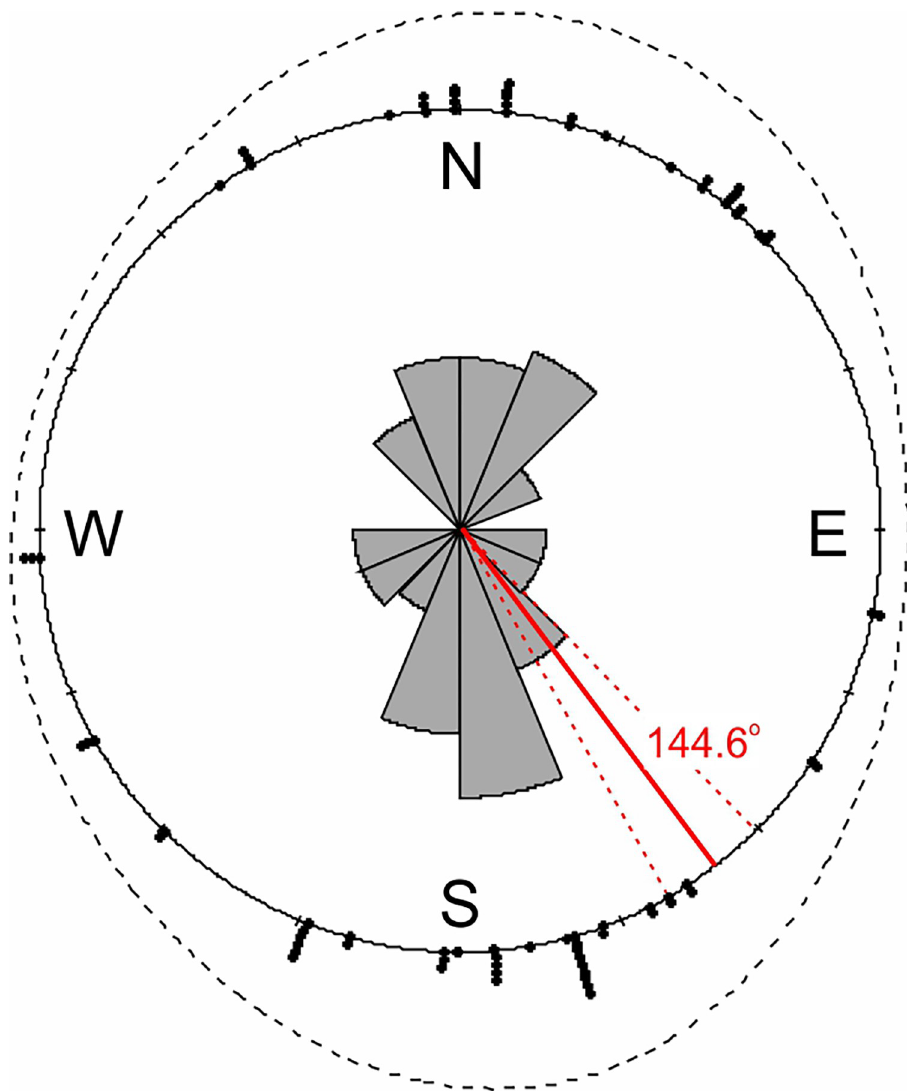
Fig 3. Distribution of Leopard ( Panthera pardus fusca ) orientation for all observations (walking and defecating). The solid red line denotes the circular mean, while the dashed red line represents the standard deviation; the black dashed line reflects the density of